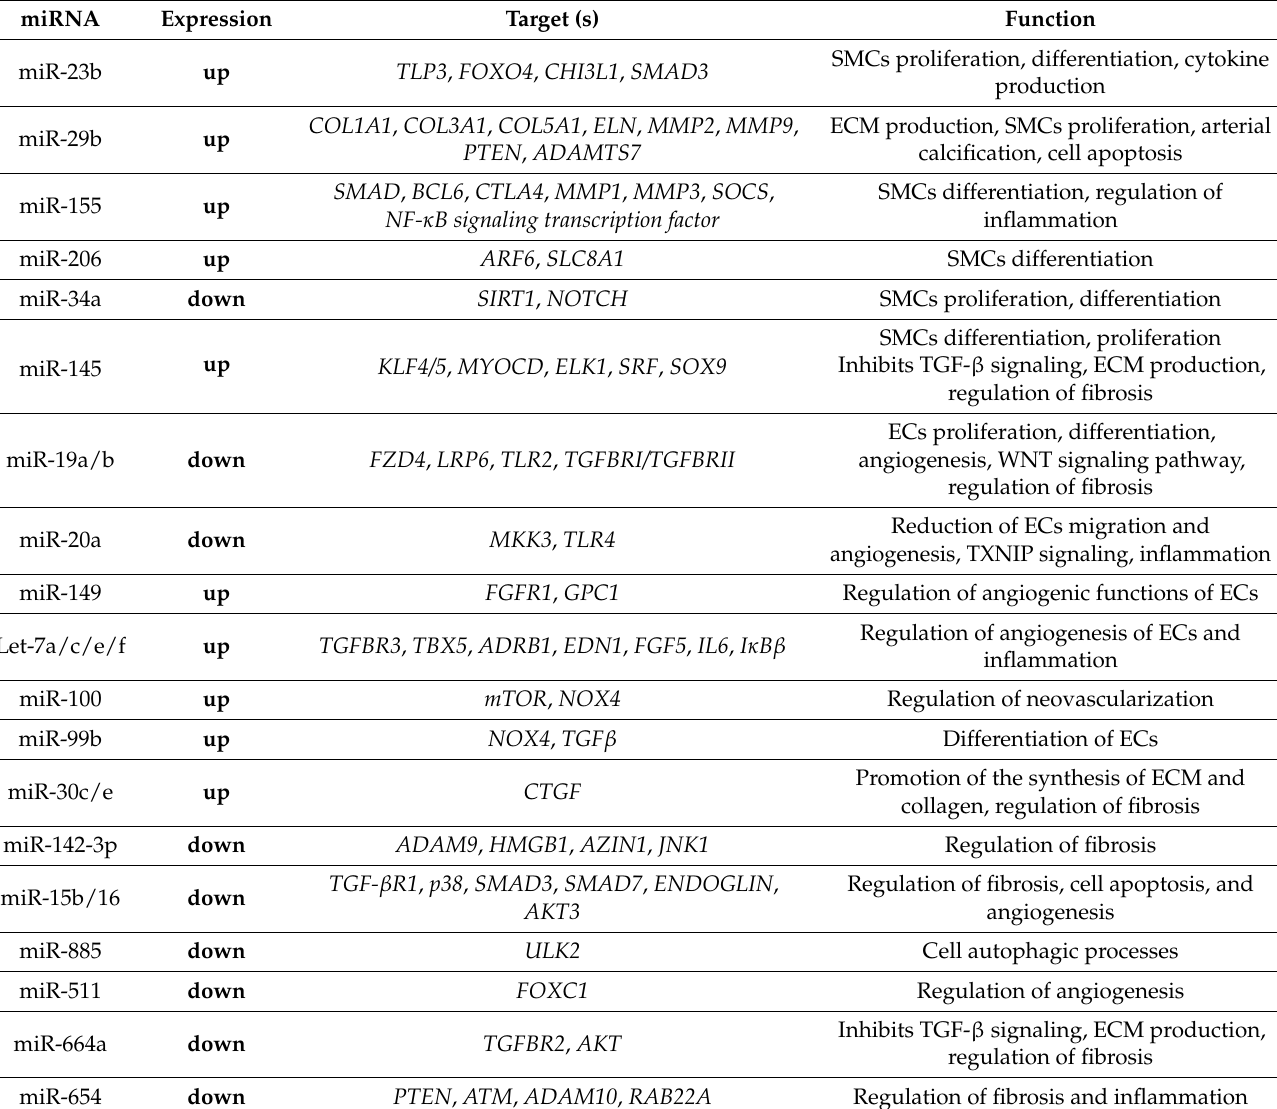
Table 1. miRNAs participated in vascular remodeling in aortic